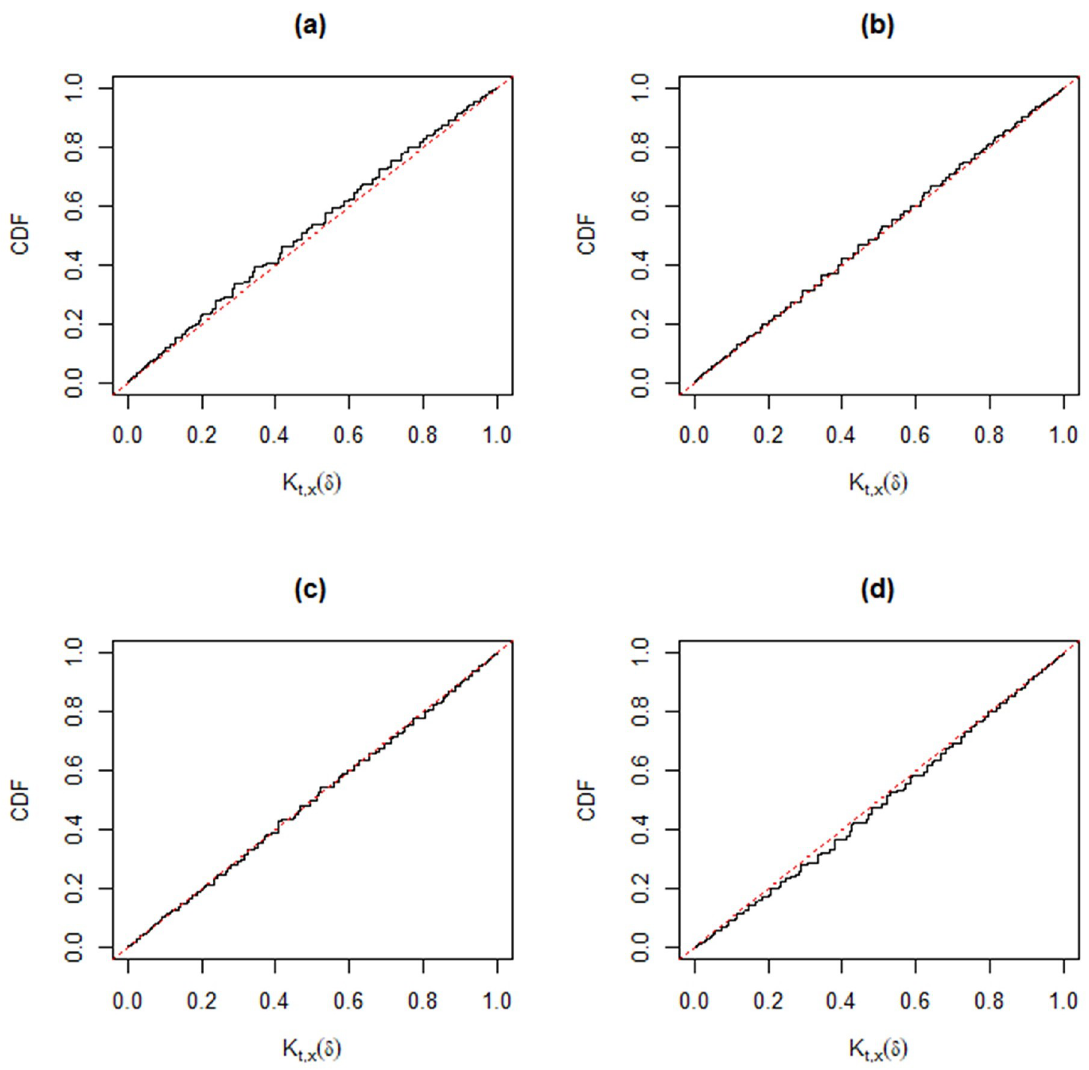
Fig 9. Distribution functions of K ( δ ) (black) compared with that of Unif(0, 1) (gray) based on Monte Carlo samples from the t , x trinomial distribution versus p 12 for fixed n = 50 and p 11 = 0.5. Panel (a): p 12 = 0.1. Panel (b): p 12 = 0.2. Panel (c): p 12 = 0.3. Panel (d): p 12 = 0.4.